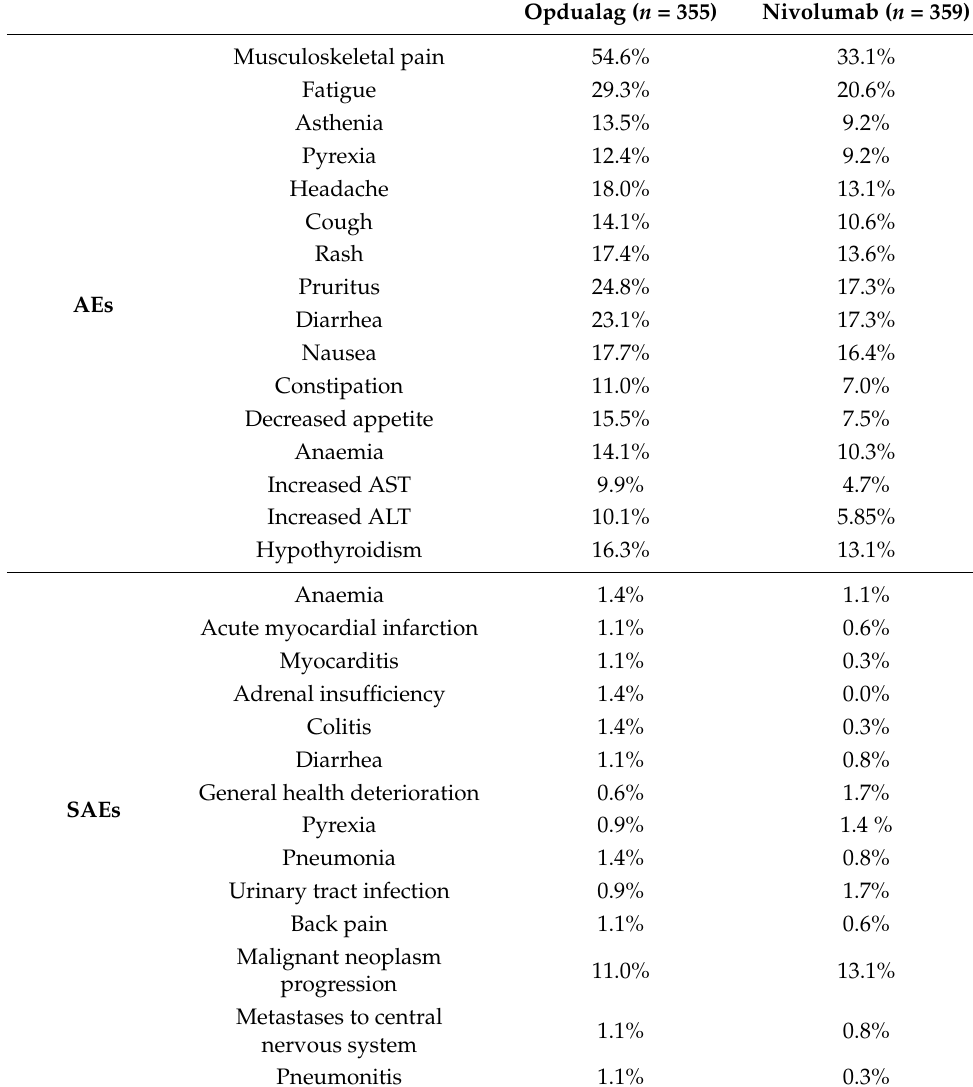
Table 1. Summary of the most common AEs and SAEs associated with the treatment with Opdualag compared to Nivolumab alone in the RELATIVITY-047 clinical trial